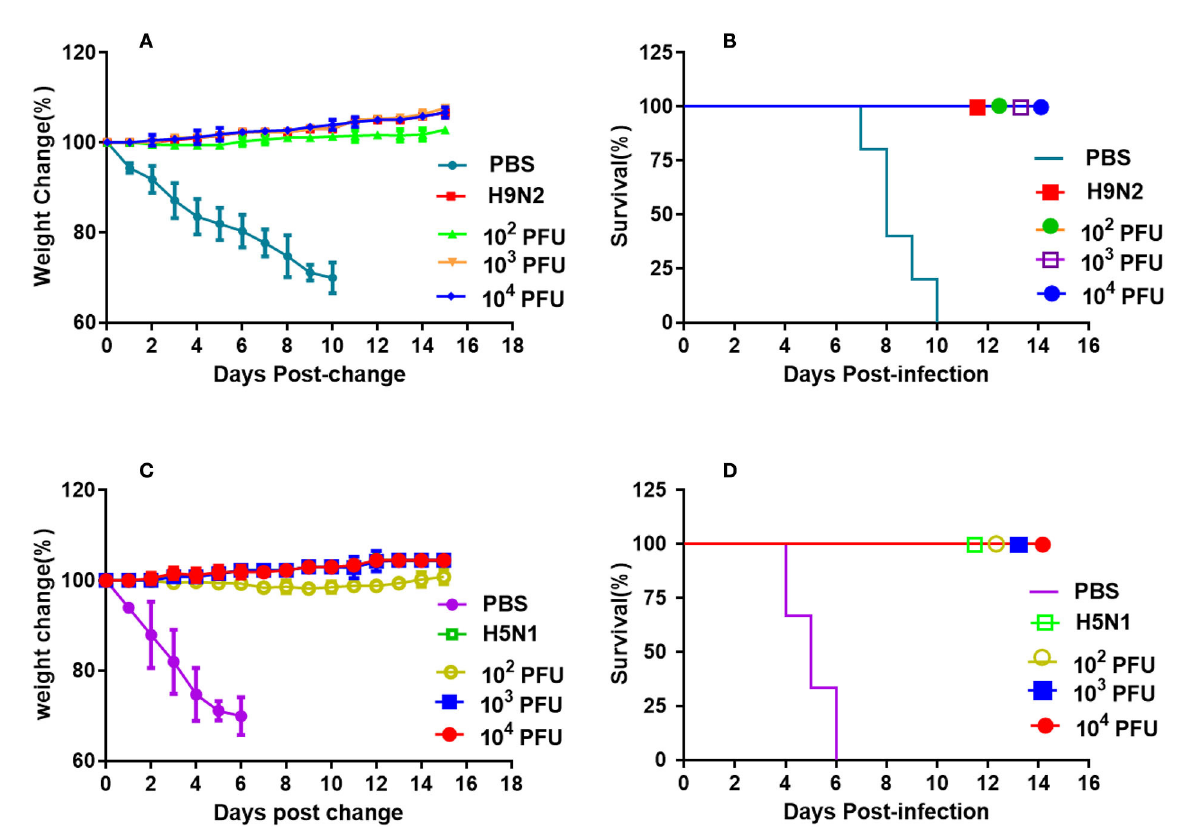
FIGURE8 Vaccination with the recombinant WM01ma-HA (H5) virus conferred protection against HN021ma and WM01ma. (A) weight changes and (B) survival rates of mice vaccinated with the recombinant WM01ma-HA (H5) influenza virus and challenged with H9N2 (WM01ma) virus, (C) weight changes and (D) survival rates of mice vaccinated with the recombinant WM01ma-HA (H5) influenza virus and challenged with H5N1 (HN01ma) virus.